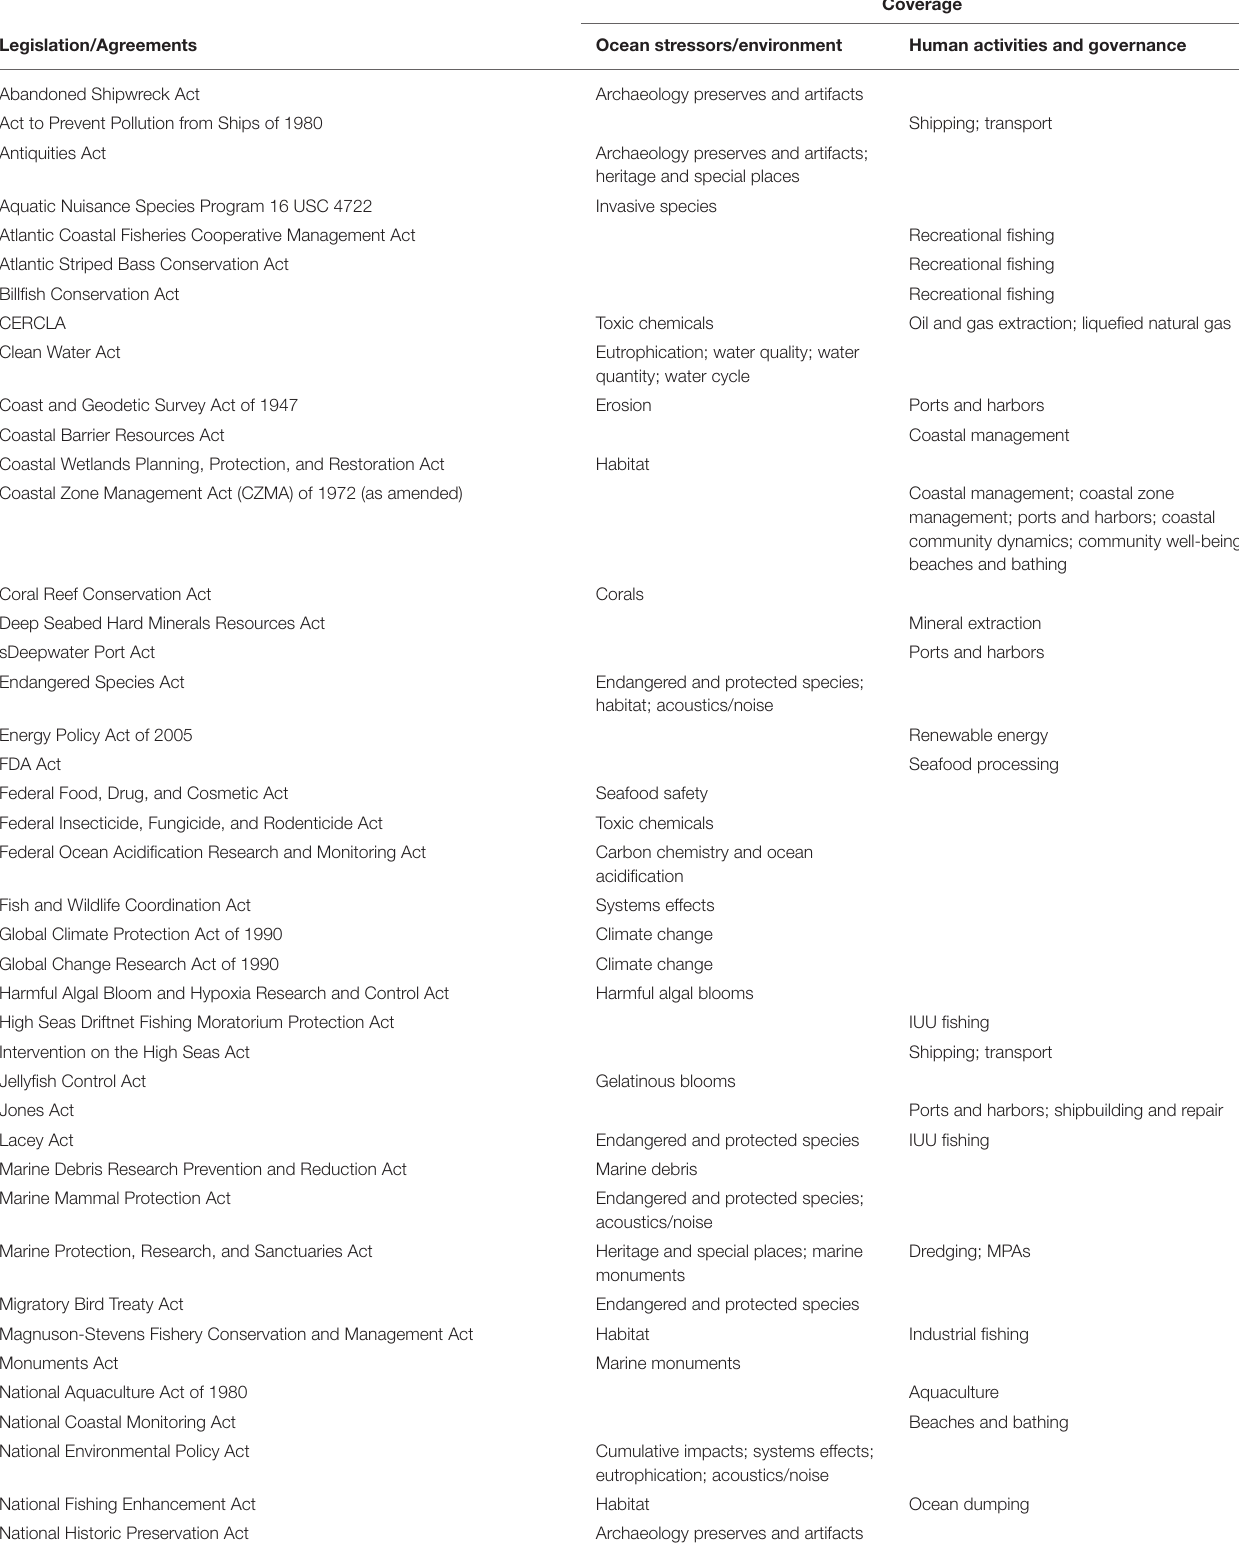
TABLE 4 | USA legislation potentially relevant for